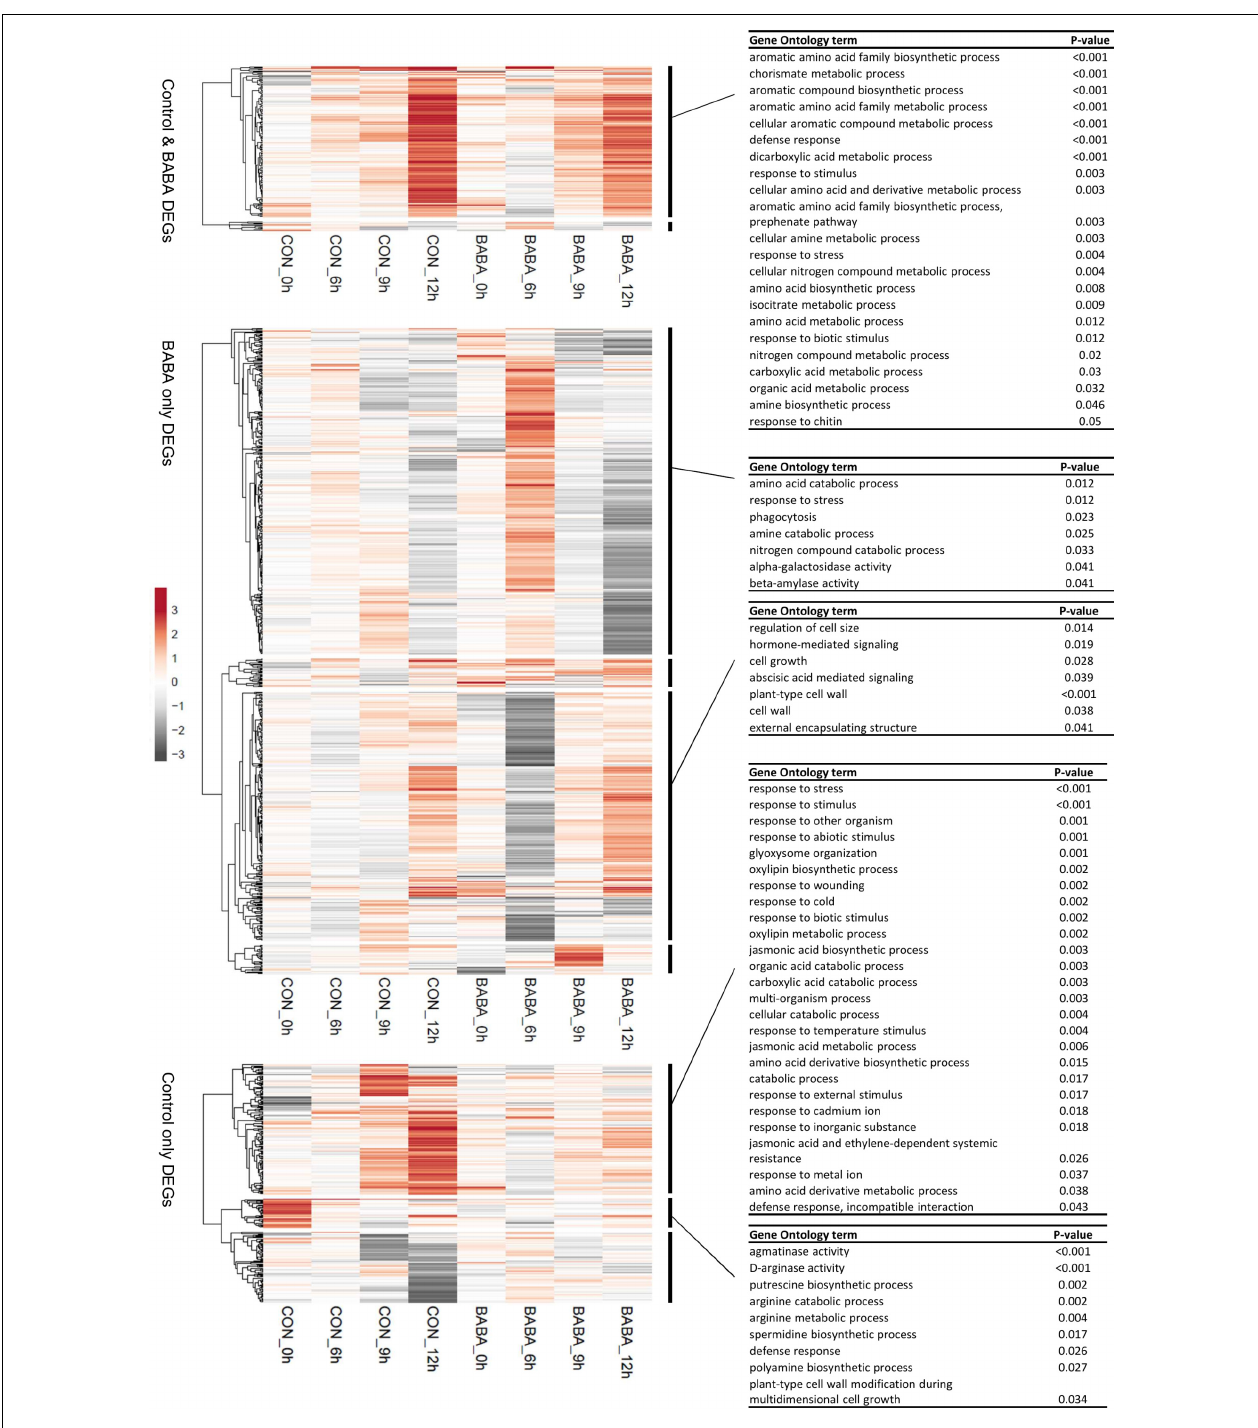
FIGURE 4 | Expression profiles of genes exhibiting differential expression in response to Botrytis cinerea infection. Hierarchical clustering was used to separately profile genes from three main categories (those differentially expressed only in control plants, only in BABA-primed plants, or in both) Clustering was performed based on log2 fold-change values ( Botrytis -inoculated relative to mock-inoculated leaves) at each time point (0, 6, 9, and 12 h post-inoculation) in control (CON) and BABA-treated leaves. Clustering of genes (rows) is based on correlation distance clustering and average linkage. Unit variance scaling was applied to rows, but values are not centred. Grey shading represents the degree of down-regulation (negative log 2 fold-change values) in infected tissues of a gene at that particular time point, whilst up-regulation (positive log 2 fold-change values) are shown in orange, and white indicates no difference in transcript levels between mock and pathogen-infected leaves. Functional profiling of the major clusters was performed using GO term enrichment analysis. Where identified, statistically significant GO terms are listed on the right of the figure.